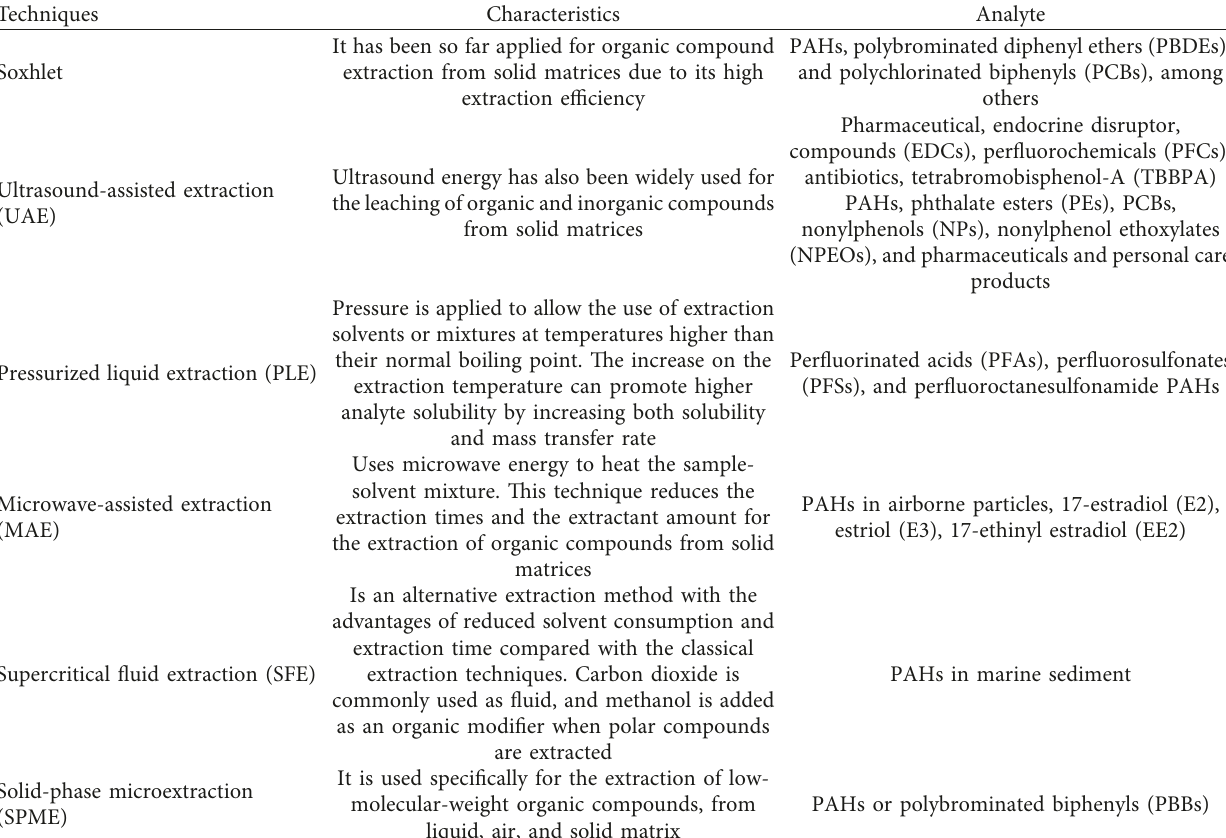
Table 5: Classification of the main extraction techniques, characteristics, and applications [44].